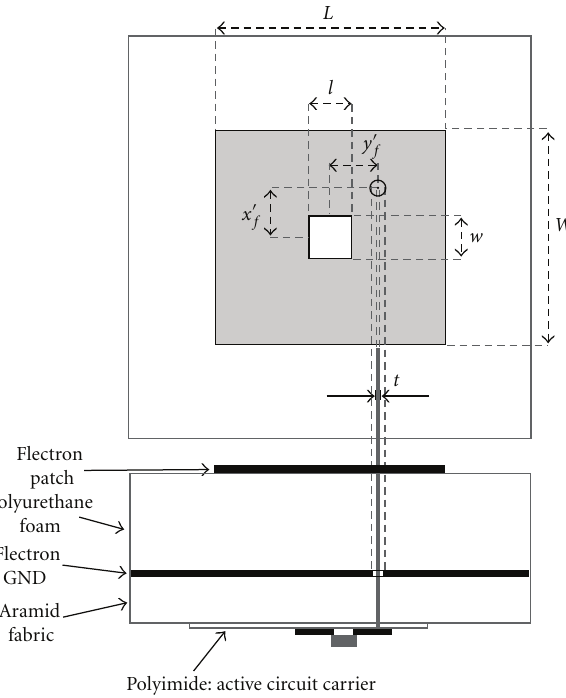
met in a very small band around the central frequency of 2.35 GHz.